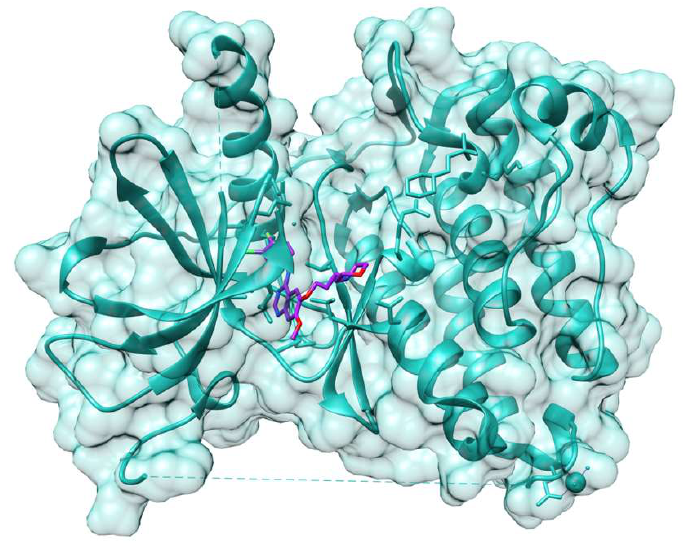
Figure 4. Gefitinib in complex with EGFR (PDB ID: 4WKQ; the image was obtained using UCSF Chimera, San Francisco, CA, U.S.A.).